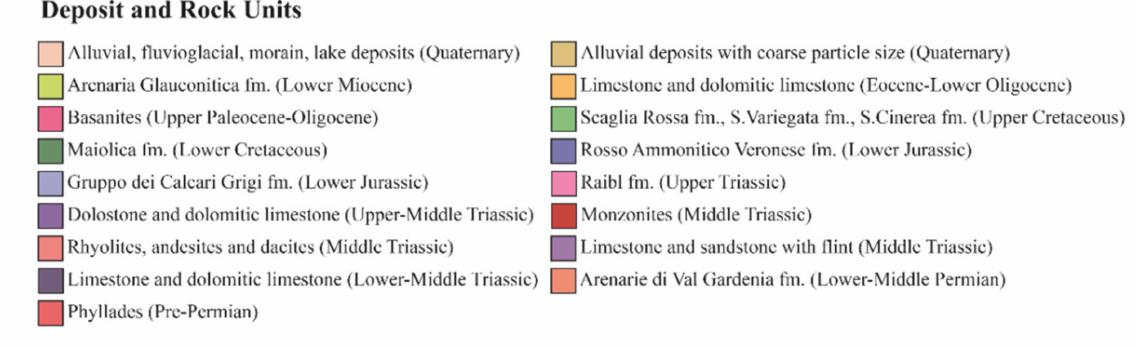
Figure 2. Geological map of the study area at Veneto compiled from literature [18] and new geological survey as part of this